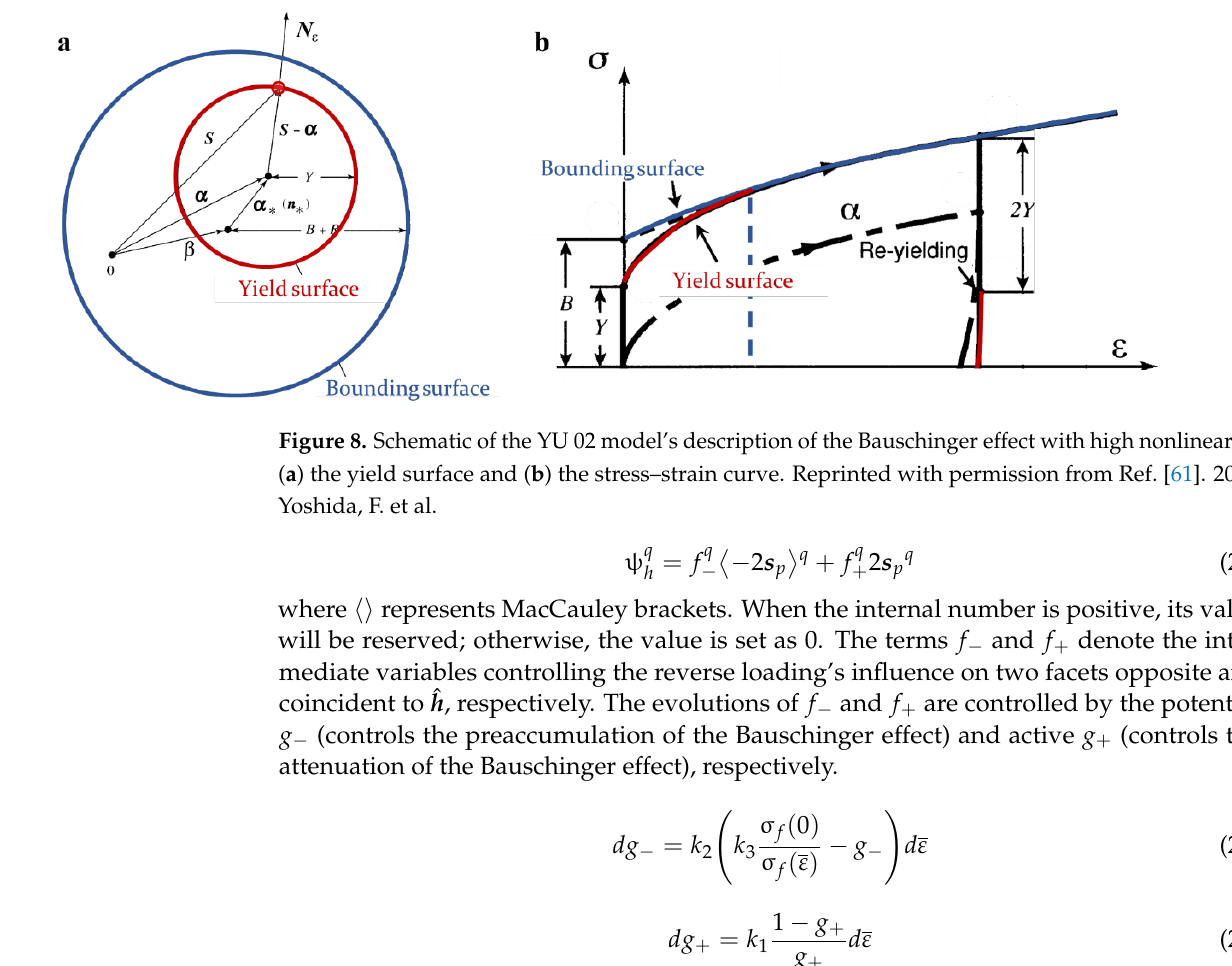
Figure 7. Features of the three decomposed back stresses in the Chaboche 86 model.